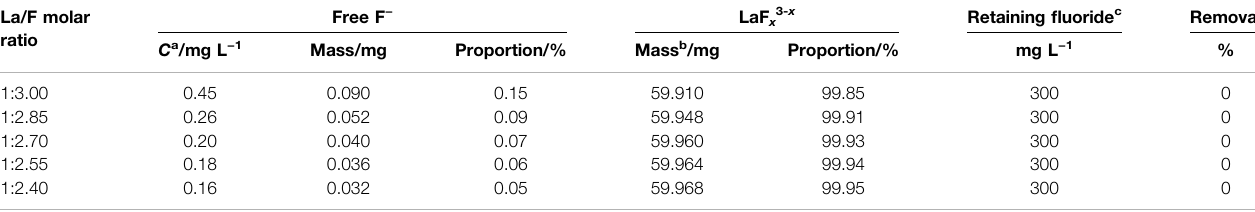
TABLE 2 | Distribution of fl uoride element in aqueous solutions with La/F molar ratio ≥ 1:3 after reaction for 1 h. La/F molar Free F − LaF x 3- x Retaining fl uoride c Removal ratio